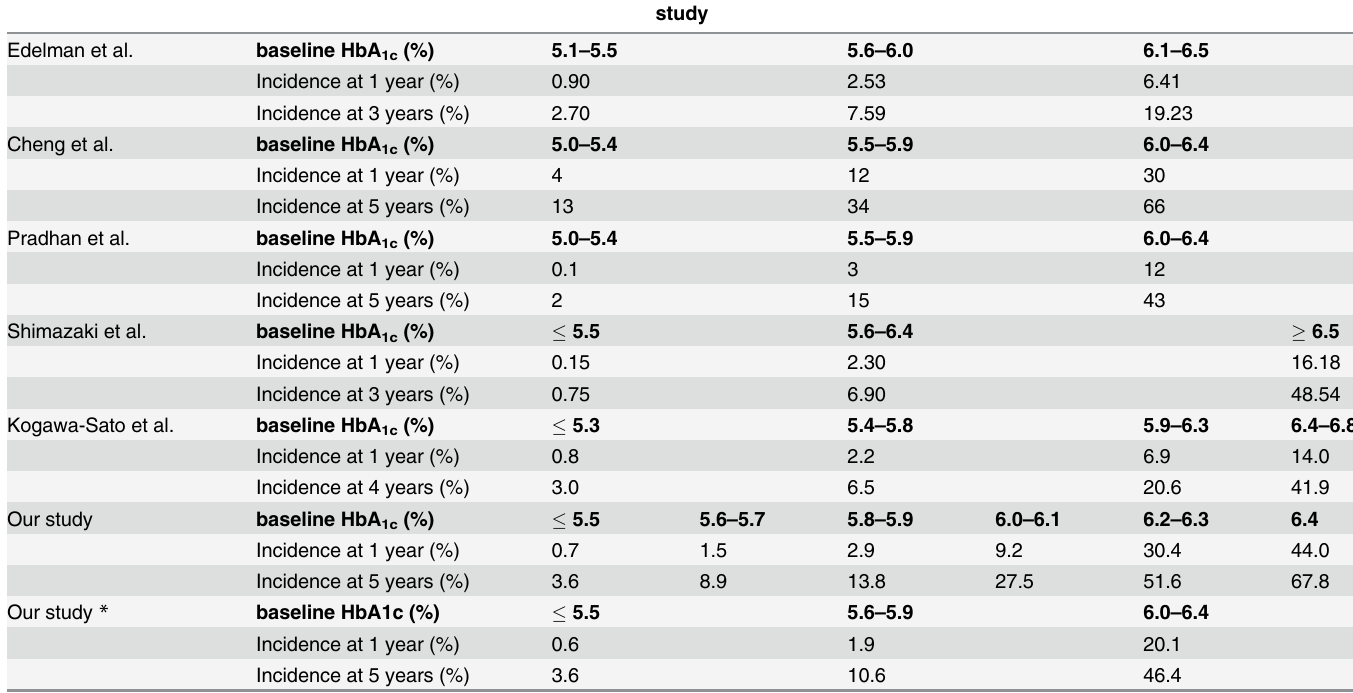
Table 5. Characteristics of the studies which evaluated the incidence of type 2 diabetes using baseline HbA 1c